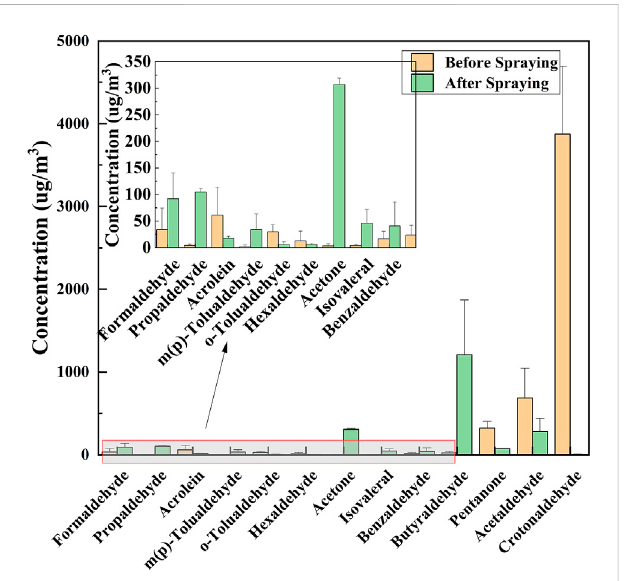
FIGURE 5 Changes in alcohol compounds before and after spraying.